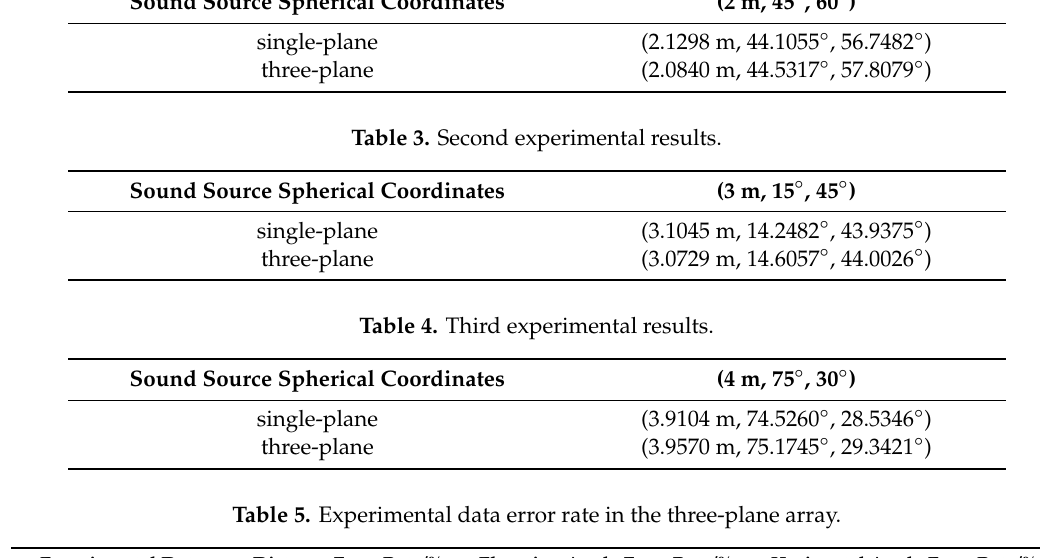
Table 2. First experimental results.